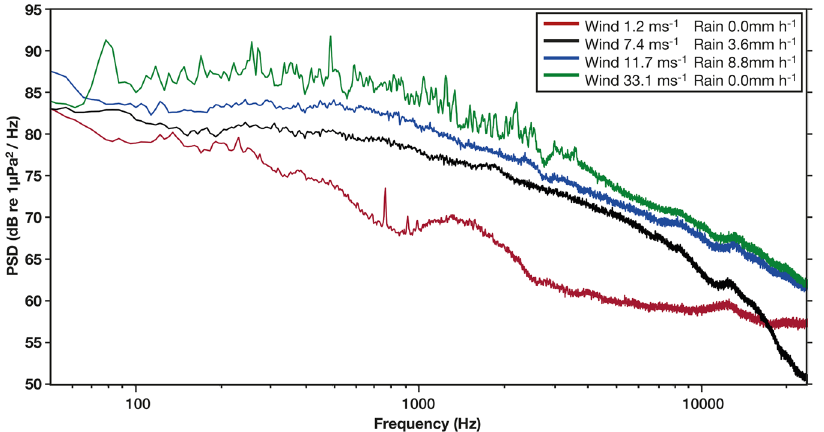
Figure 3. Power spectrum levels of four weather scenarios, produced using FFT length = 16384 points, Hanning window and 50% overlap. Red line - low wind speed 1.2 ms − 1 and low rainfall 0.0 mmm h − 1 . Black line - medium wind speed 7.4 ms − 1 and medium rainfall 3.6 mmm h − 1 . Blue line - high wind speed 11.7 ms − 1 and high rainfall 8.8 mmm h − 1 . Green line - gale warning wind speed 33.1 ms − 1 and low rainfall 0.0 mmm h − 1 . Each line represents a single event taken as an example of the corresponding weather scenario.